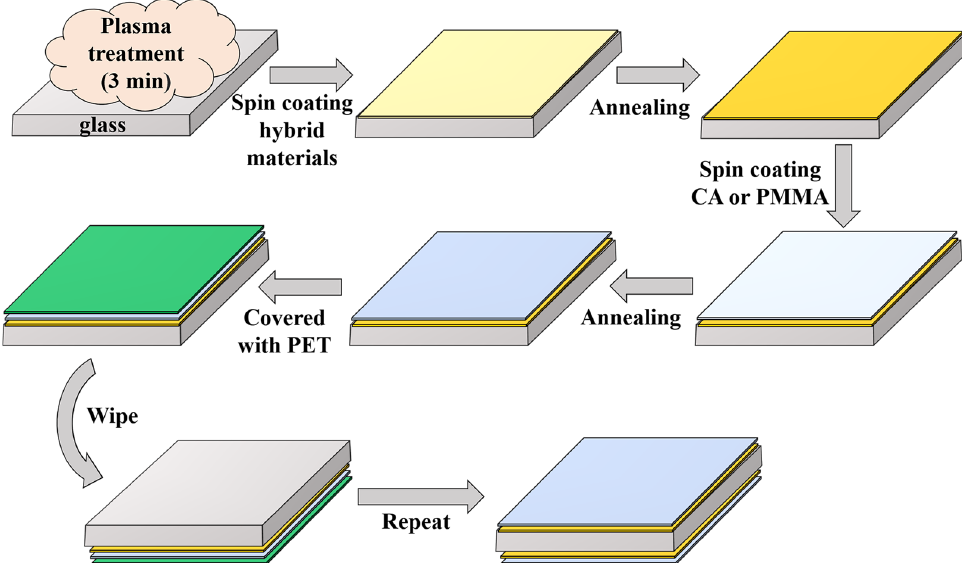
Figure 6. Fabrication flow of large ‐ area double ‐ sided antireflection film.